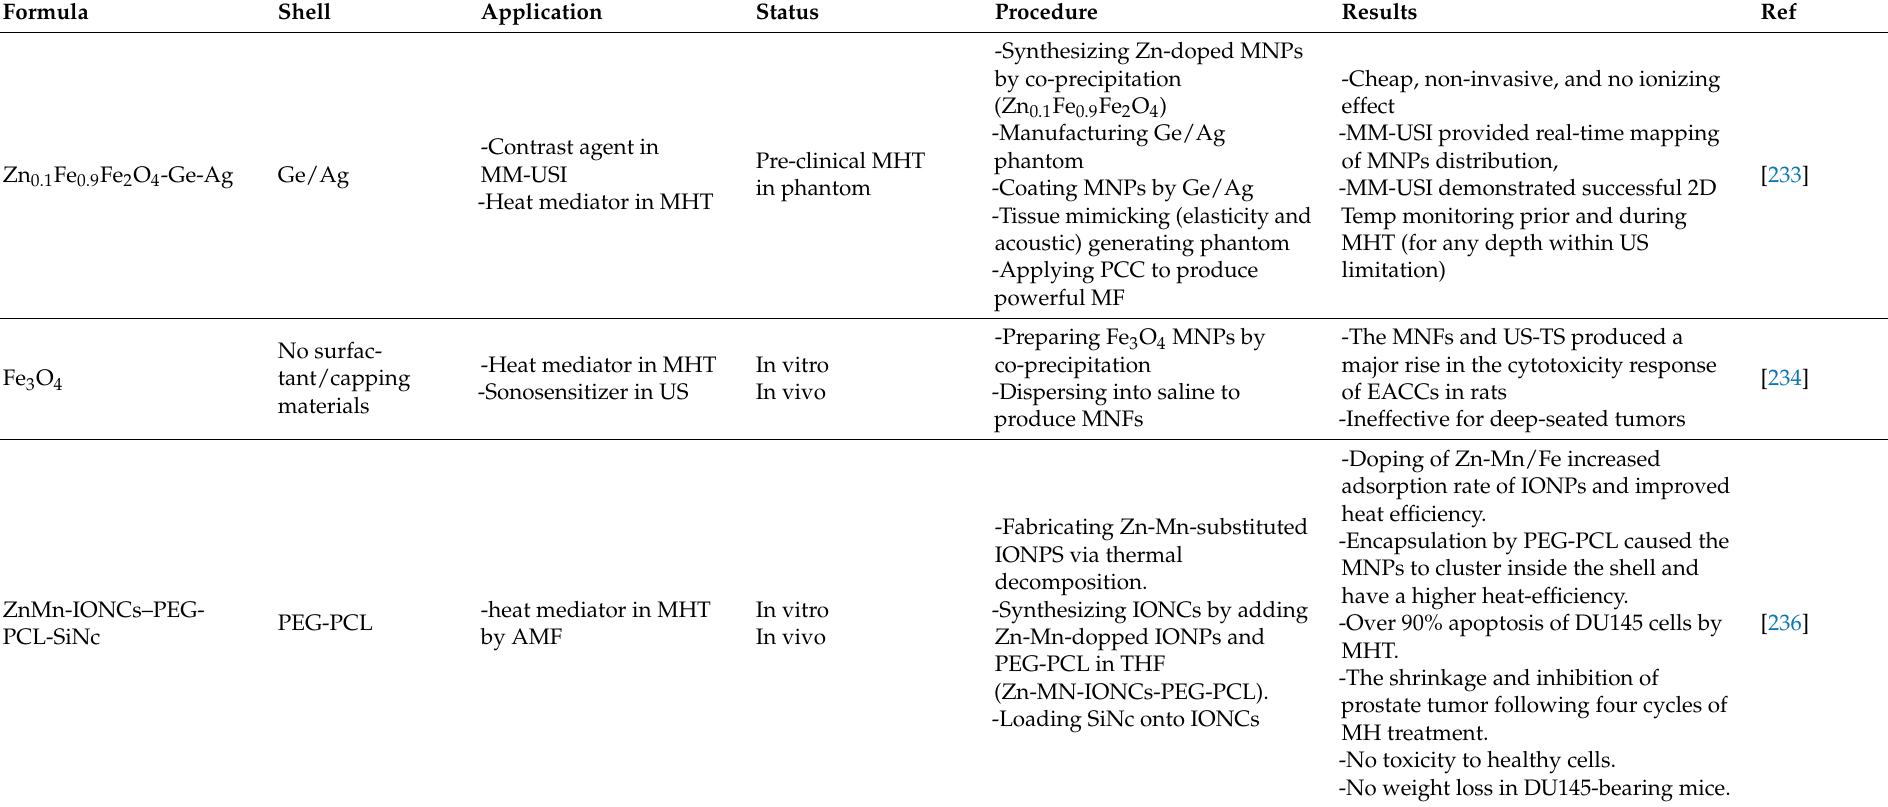
Table 6. The pre-clinical studies of Thermo-sensitive MNPs in MHT therapy for theranostic